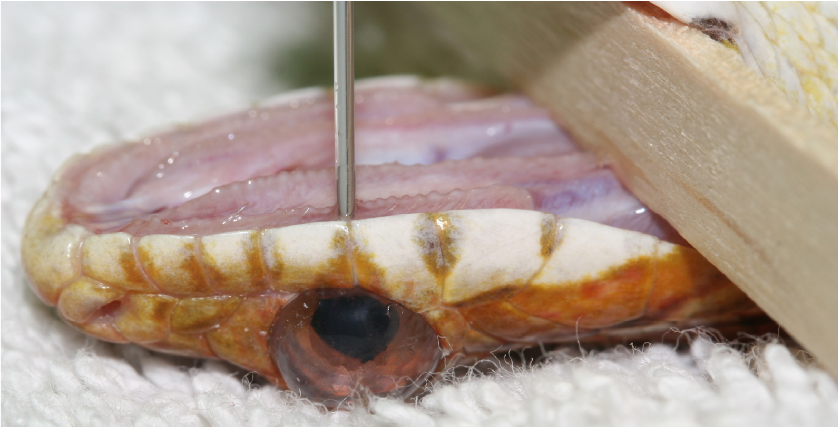
Figure 42. Conjunctivoralostomy performed in a corn snake ( Pantherophis guttatus ) with pseudobuphthalmos comprises the creation of a new channel. In this case, a metal cannula is advanced from the fornix between the lateral maxillary teeth and the facial skin to the ventral subspectacular space as the initial step of the procedure.